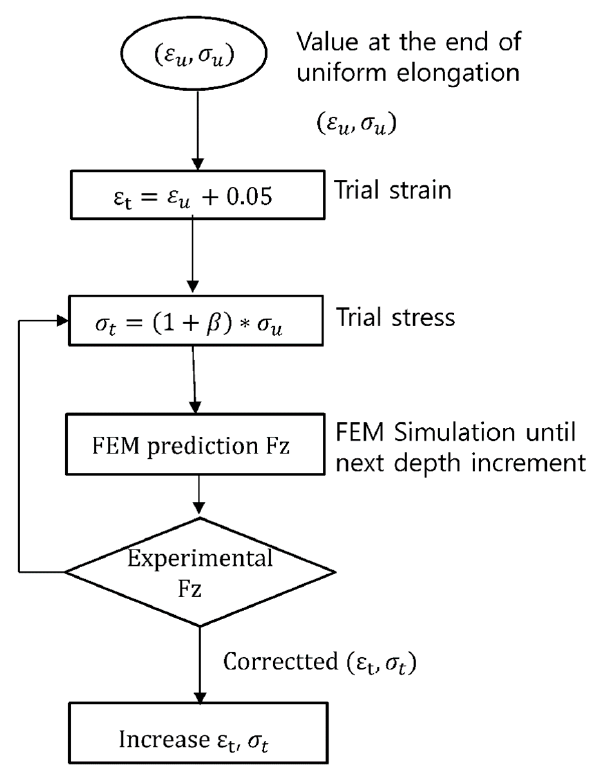
Figure 8. Stress integration process.